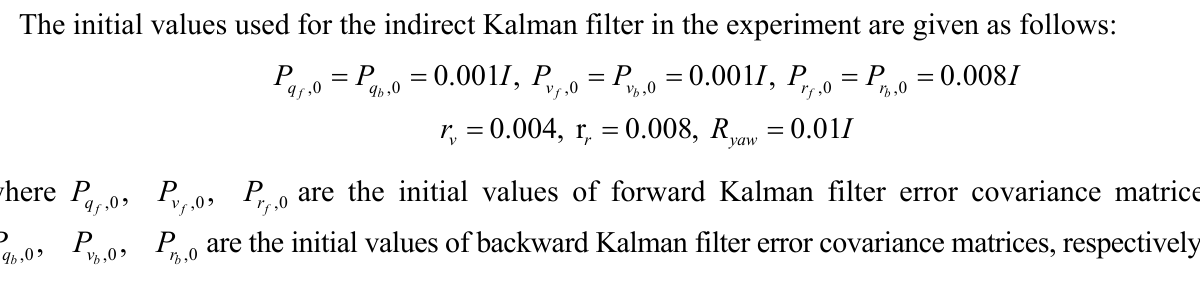
Figure 6. Table experiment (